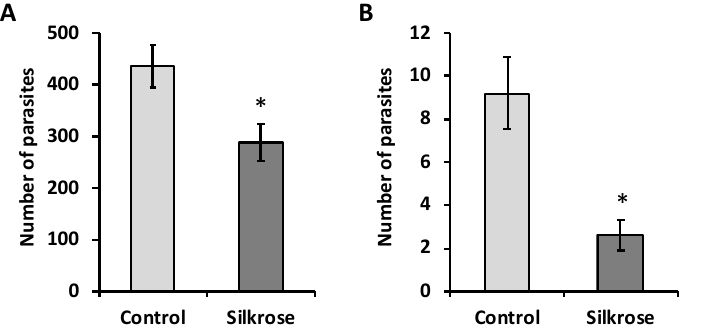
Figure 5. Effect of silkrose treatment on the number of parasites of ( A ) Caligus longipedis and ( B ) Neobenedenia girellae per individual white trevally at aquaculture field site. Results are presented as mean ± standard error. Asterisk indicates statistically significant differences compared with control group (* p < 0.05).